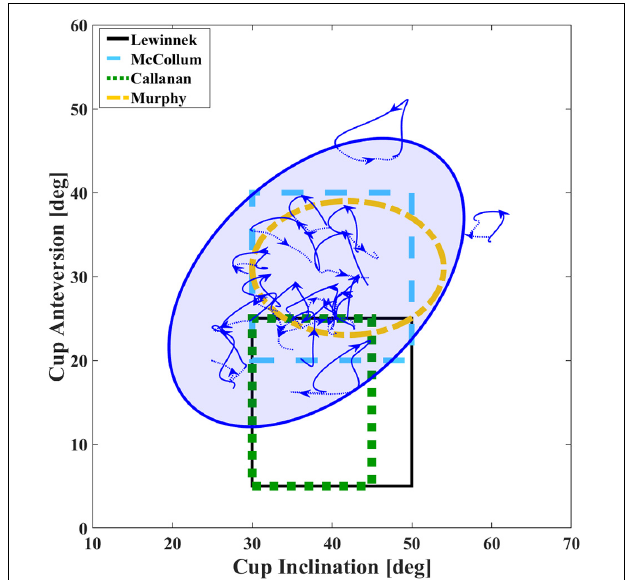
FIGURE 4 | Average dynamic functional acetabular anteversion and inclination of total hip arthroplasty (THA) during gait. Different definitions of safe zones are shown (Lewinnek et al., 1978; McCollum and Gray, 1990; Callanan et al., 2011; Murphy et al., 2018). The blue 95% group ellipse represents distribution of functional acetabular orientation during gait for the THA